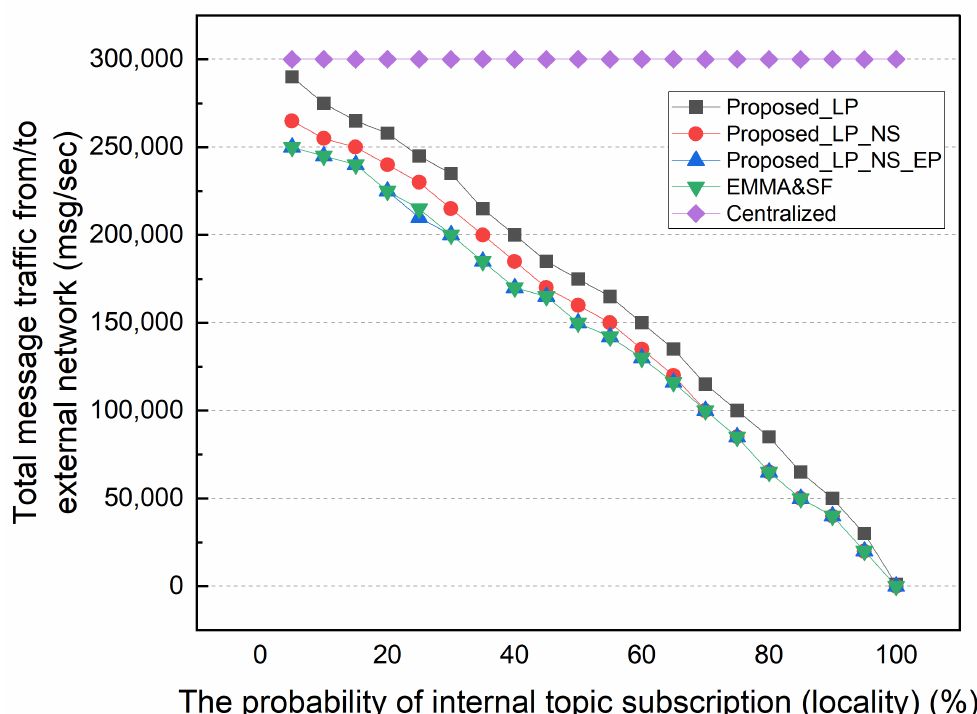
Figure 8. Message traffic between external networks by subscription